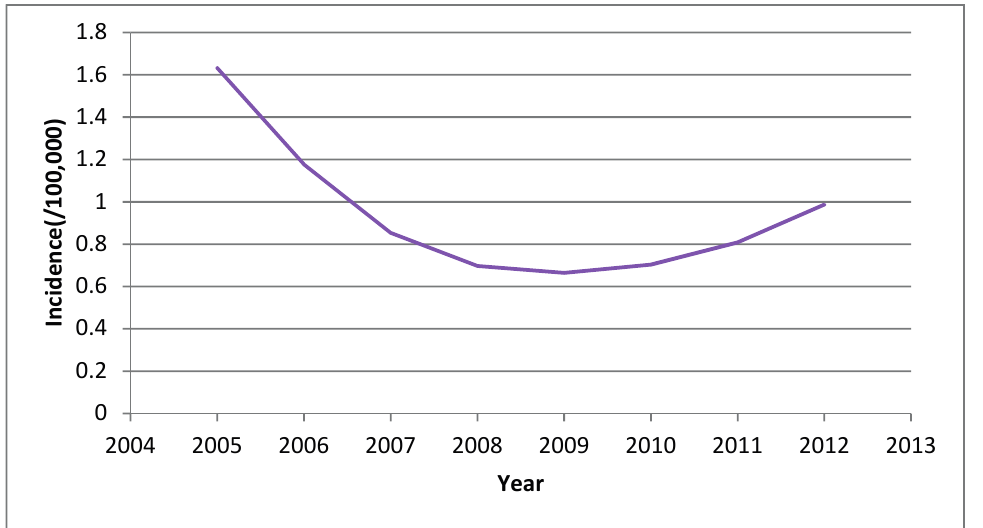
Figure 1. The incidence of HFRS in China,